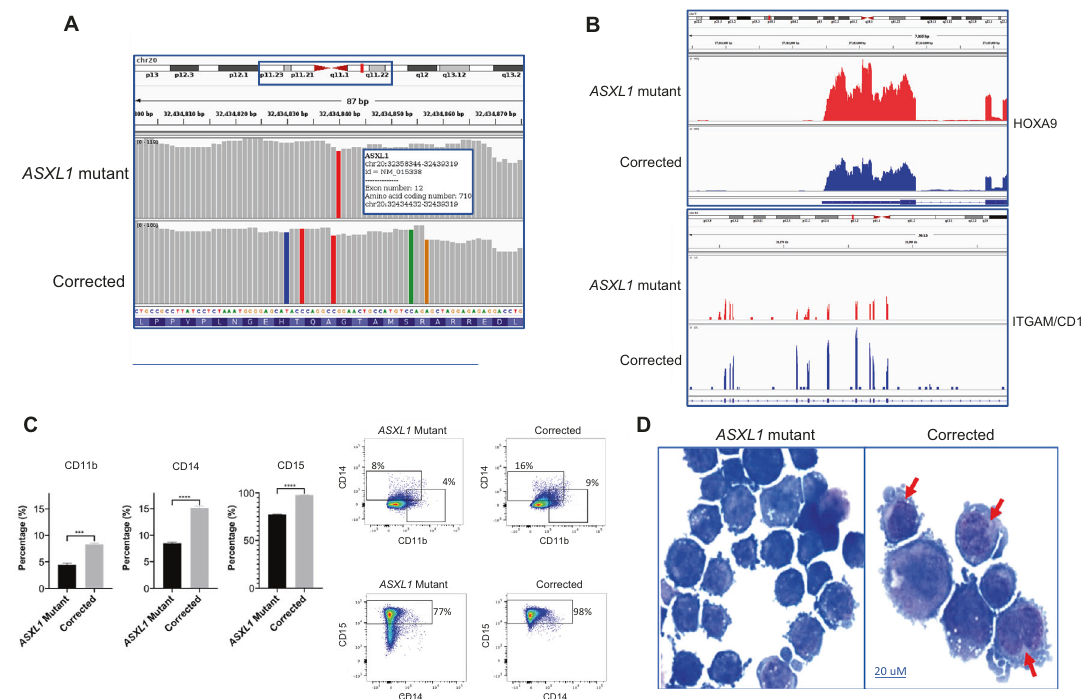
Fig. 1 CRISPR/Cas9-mediated correction of the ASXL1 mutation leads to increased myeloid differentiation. A The ASXL1 gene is made up of 12 exons with the ASXL1 G710X mutation in KBM5 cells located in exon 12. RNA-sequencing demonstrates CRISPR/Cas9-mediated correction of the ASXL1 G710X mutation in the leukemic KBM5 cell line. For the ASXL1 mutant cells, the red bar demonstrates the presence of the ASXL1 mutation at amino acid location 710, exon 12, chromosome 20. For the corrected cells, the red bar is absent at amino acid location 710, exon 12, chromosome 20, demonstrating correction of the ASXL1 mutation. In addition, the different colored bars in the corrected trace demonstrate silent nucleotide changes that were introduced to avoid undesired Cas9 activity in the mutation-corrected cells. B RNA- sequencing demonstrates that correction of the ASXL1 G710X mutation in the KBM5 cells by CRISPR/Cas9 gene-editing results in decreased expression of the HOXA9 gene. Increased expression of ITGAM/CD11b is demonstrated in the corrected isogenic cell line, suggesting increased myeloid differentiation. C Flow cytometry demonstrates increased expression of three myeloid surface markers, CD11b, CD14, and CD15, in the corrected cell line compared to the ASXL1 mutant cells, demonstrating increased myeloid differentiation with correction of the ASXL1 G710X mutation. Representative plots are shown. D Representative images of Giemsa stained ASXL1 mutant cells and those with homozygous correction of the ASXL1 G710X mutation. Red arrows identify cells with decreased nucleus to cytoplasm ratio and condensed nuclei, consistent with myeloid